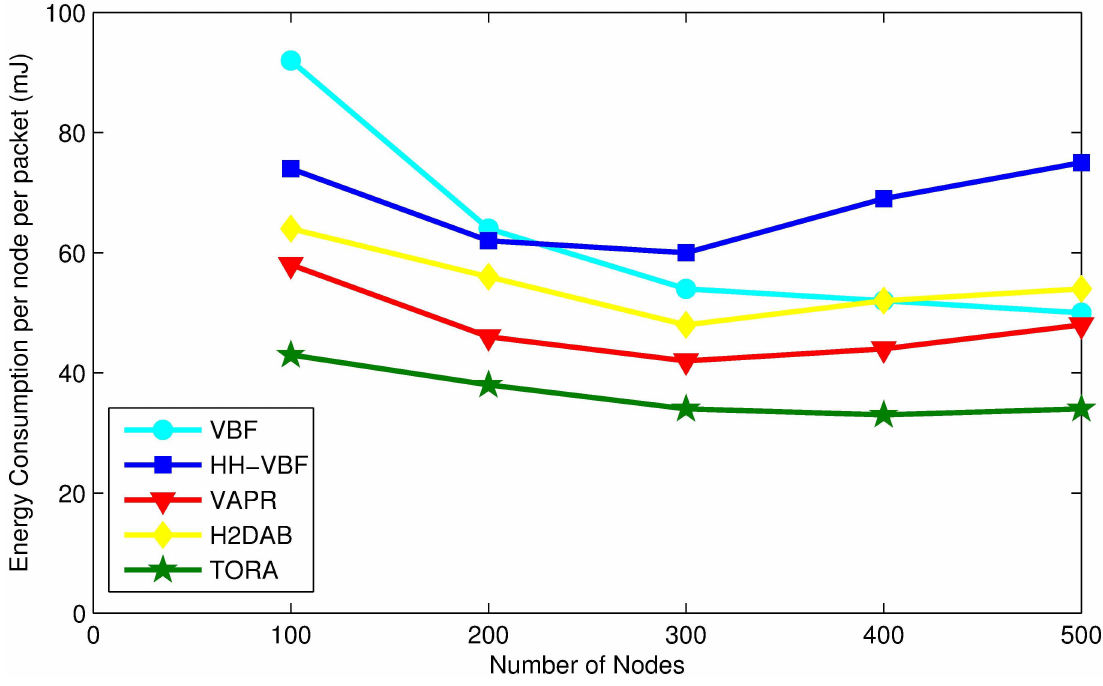
Fig 8. Energy consumption per node per message vs. node